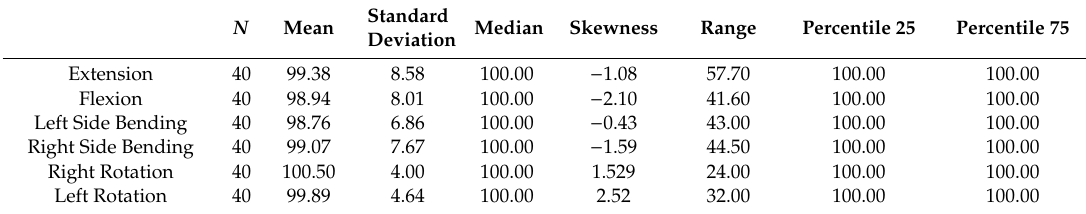
Table 5. Control group normalized values of ROM using our own